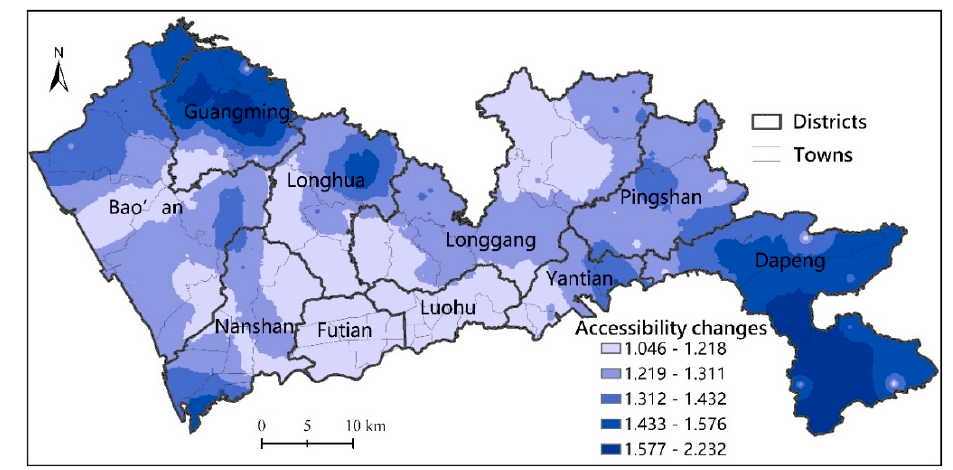
Figure 5. The distribution of improving–efficiency accessibility impacts in Shenzhen.